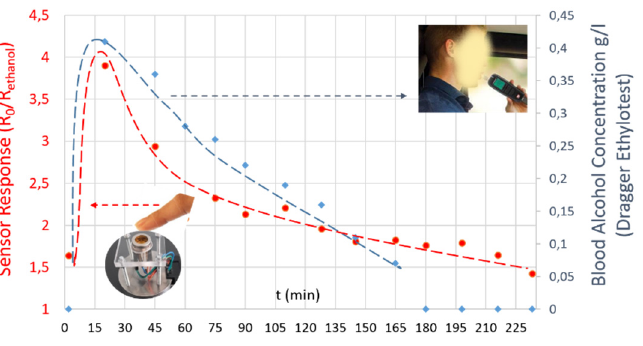
Figure 14. A comparative study between gas sensors responses obtained during the transdermal detection, and the blood alcohol concentration deduced from the DRAGER 6820 certified breathalyzer.